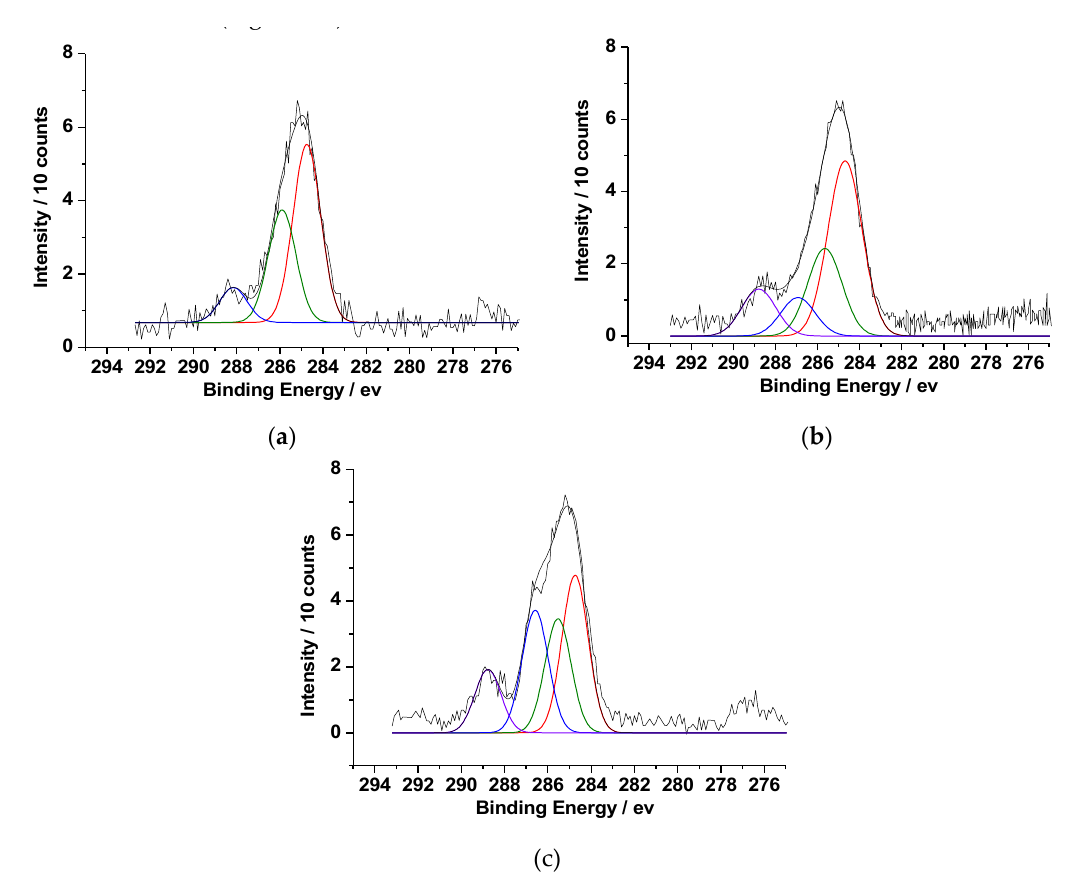
Figure 4. X-ray photoelectron spectra at the C1s region for ( a ) MSN-PDEAEMA, ( b ) MSN-PDEAEMA-Cys, and ( c ) MSN- PDEAEMA-Cys-POEGMEMA.